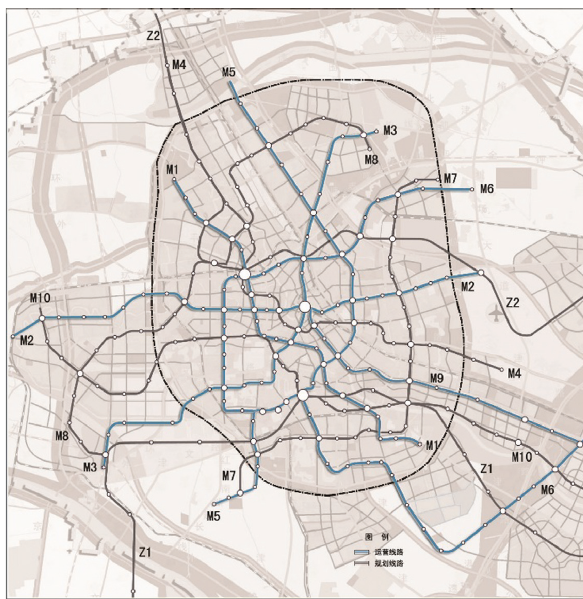
Figure 2: The urban rail transit line planning network of Tianjin in 2020.